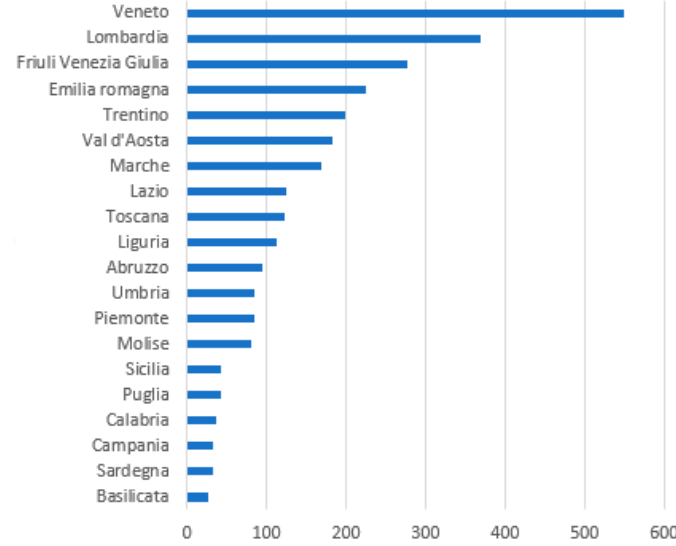
Figure3. Numberoforopharyngealswab(OPS) / nasopharyngealswab(NPS)per1,000,000inhabitantsin Figure 3. Number of oropharyngeal swab (OPS)/ nasopharyngeal swab (NPS) per 1,000,000 Italian regions (period March–April 2020) Elaborazione GIMBE dati Protezione Civile —https: // coronavirus. inhabitants in Italian regions (period March – April 2020) Elaborazione GIMBE dati Protezione Civile - gimbe.org / https://coronavirus.gimbe.org/ [88].